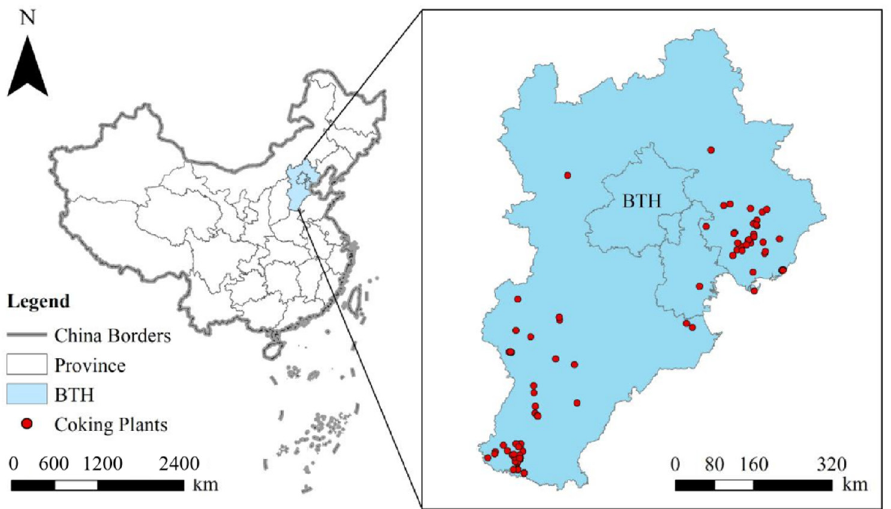
Figure 1. Location of coking plants in Beijing–Tianjin–Hebei Region, China.